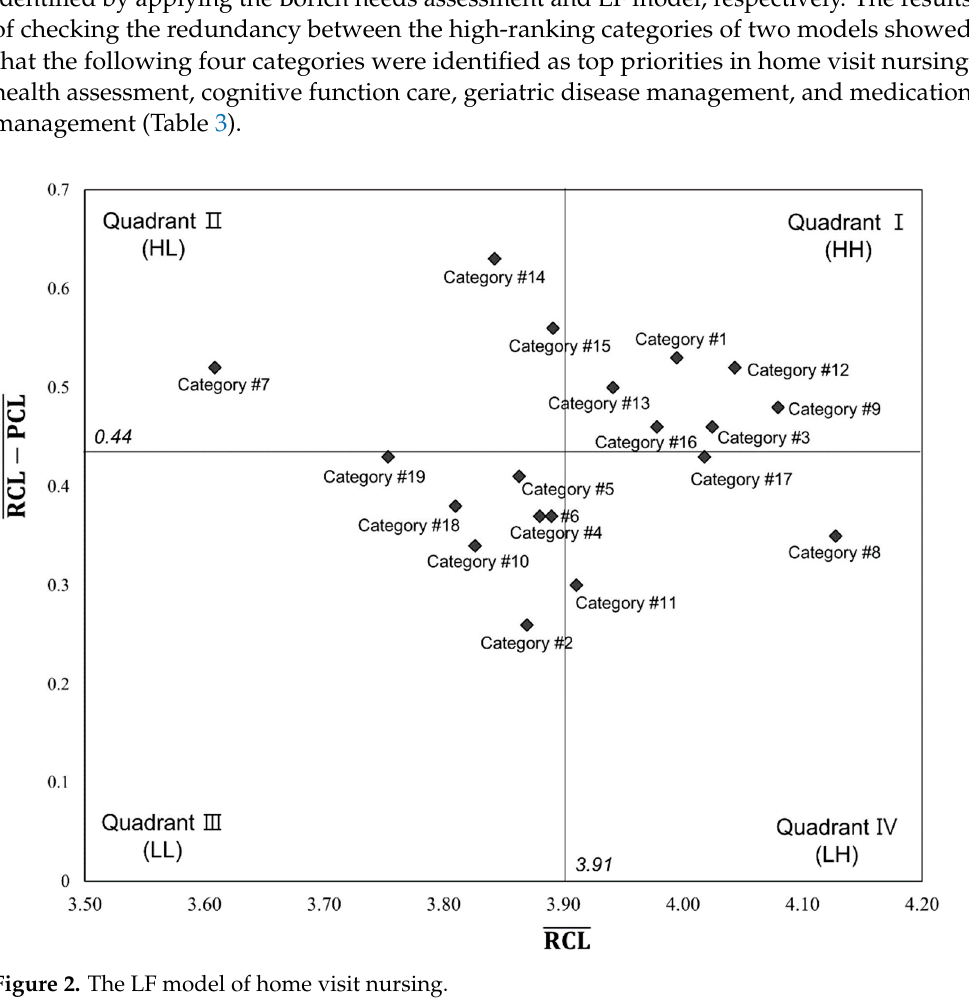
Table 2. Educational needs in home visit nursing ( N = 92).